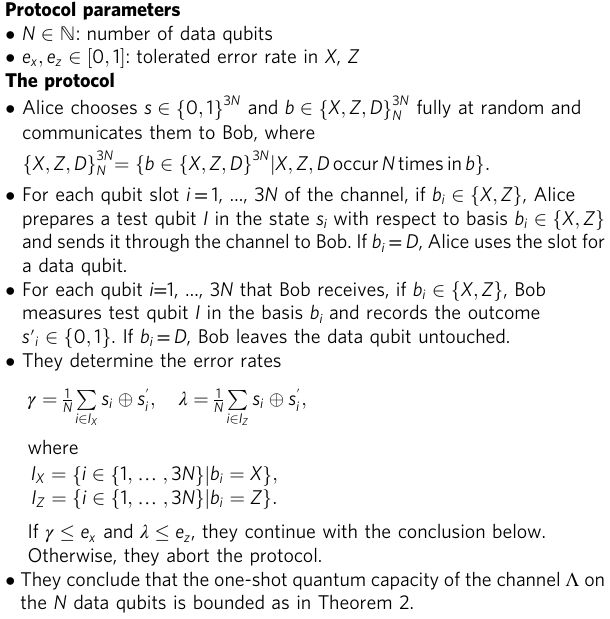
Table 2 Protocol 2: The veri fi cation protocol One-shot quantum capacity veri fi cation Protocol parameters • N 2 N : number of data